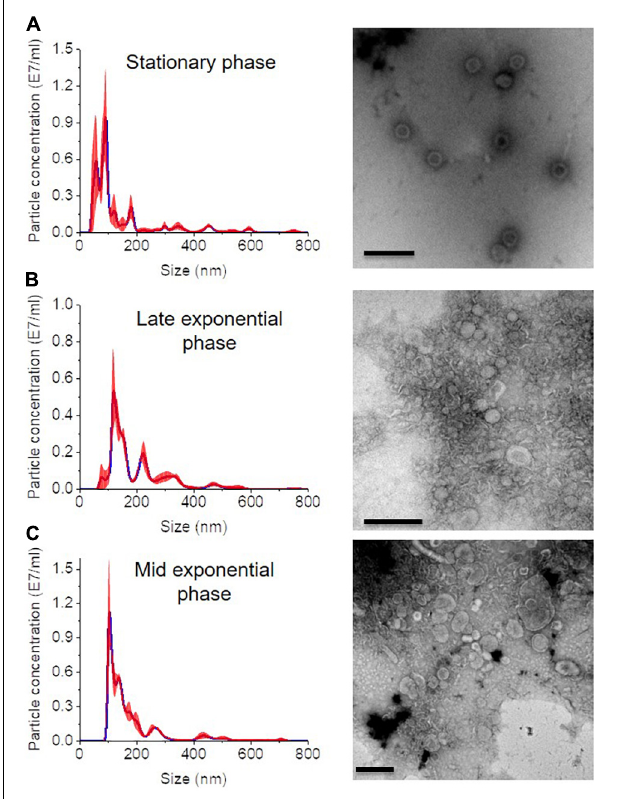
FIGURE 4 | Nanosight analysis and respective TEM images of OMVs at different growth phases (A) stationary phase (pH: 5.1) (B) late exponential (pH: 5.3) and (C) mid-exponential phase (pH: 5.7). Each sample is measured three times. Scale bar, 200 nm.